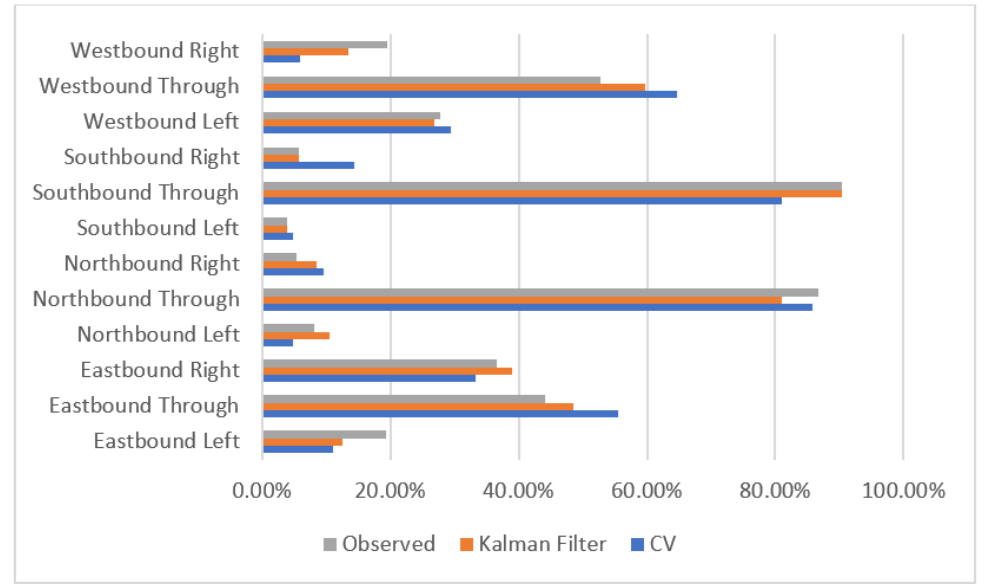
Figure 11. Comparison of CV, KF, and Observed TM Percentages for 4:15 – 6:15 p.m. 24 August 2021.